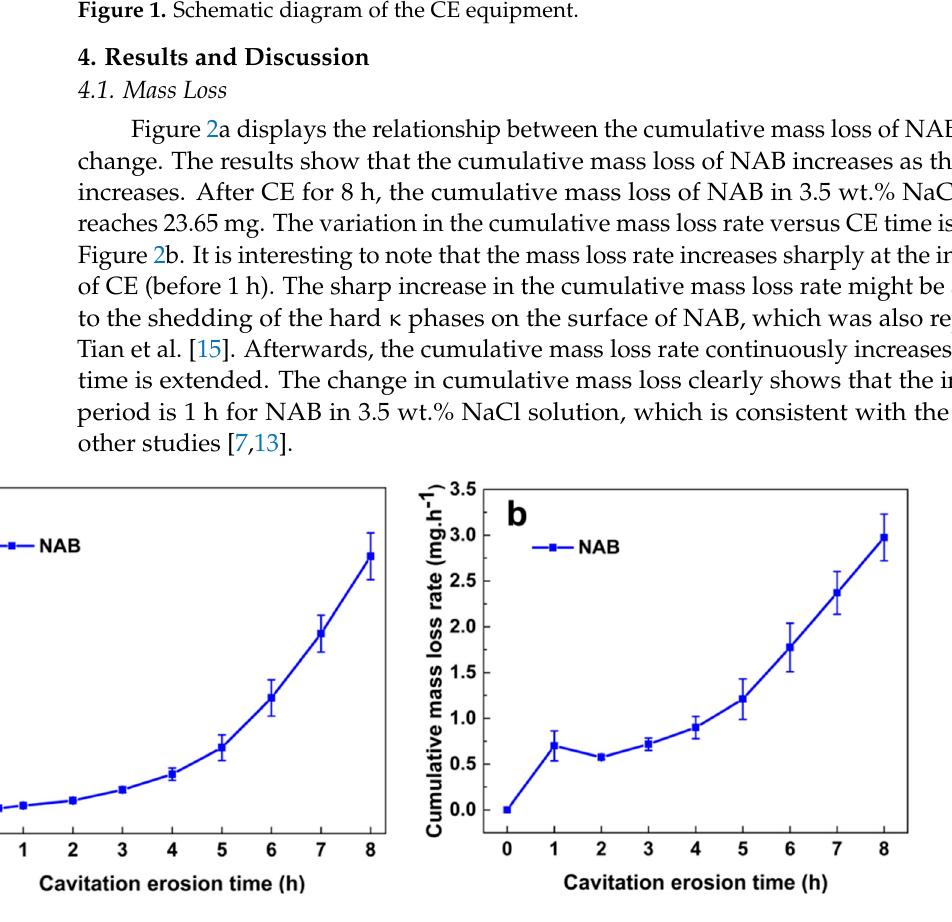
Figure 2. Cumulative mass loss ( a ) and cumulative mass loss rate ( b ) of NAB after different CE